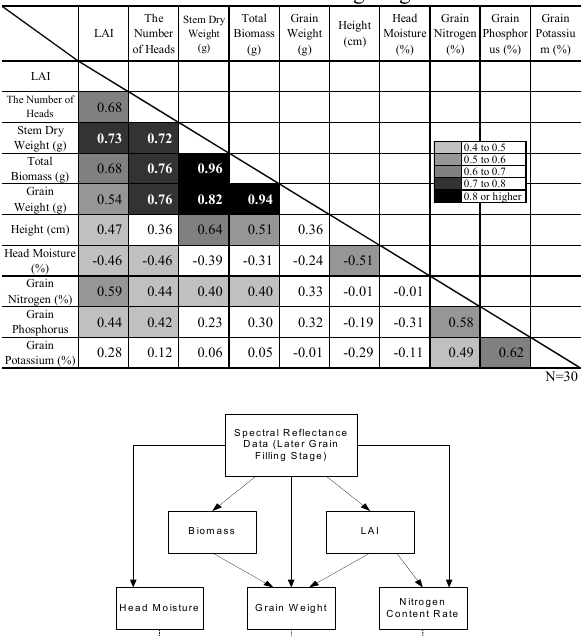
Table 2: Correlations between Estimation Items